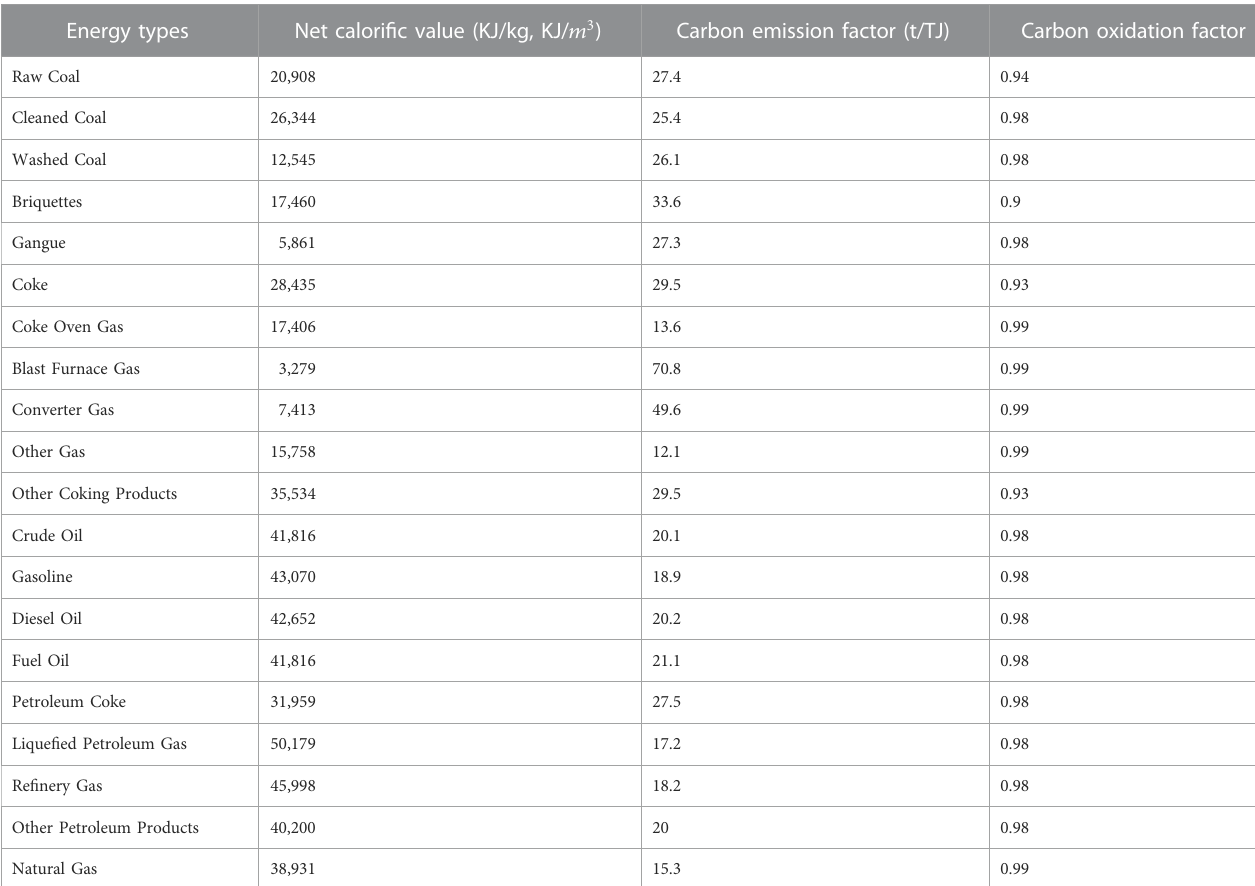
TABLE 1 Energy types and coef fi